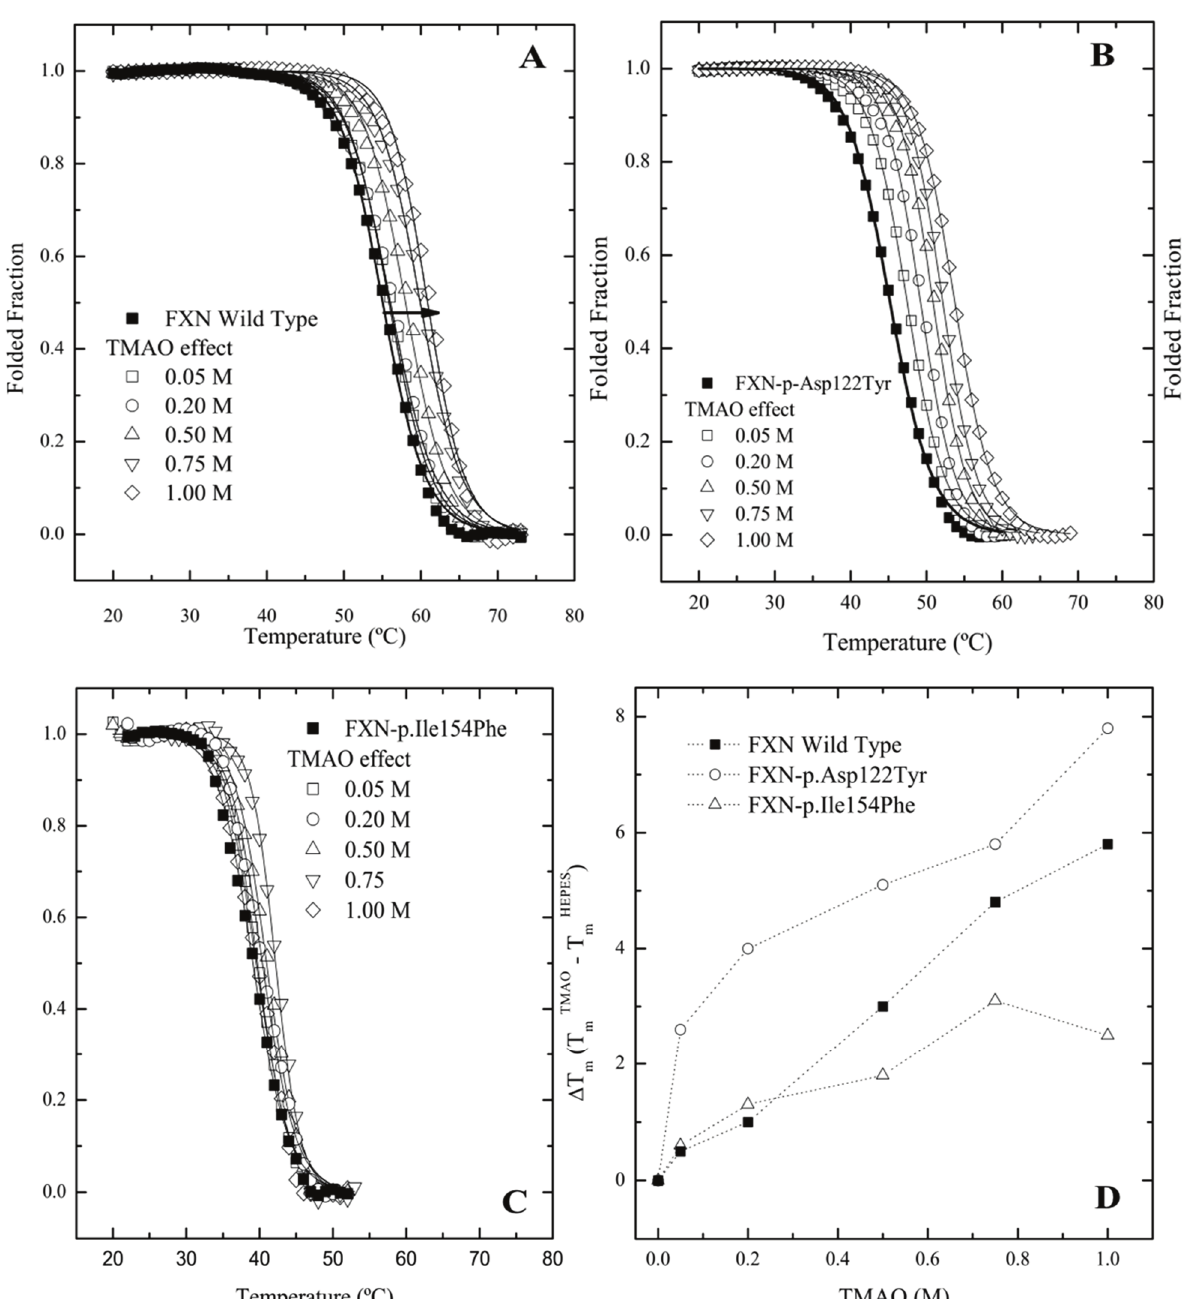
Figure 4. Differential Scanning fluorimetry (DSF) of native and variant frataxins in the absence and presence of TriMethylAmine N-oxide (TMAO). The concentration of frataxin was 4 μM. The dye Sypro orange was used to probe the temperature dependent protein unfolding reaction. The starting apparent kinetic T m values without osmolyte were 55.1 °C for wild type FXN ( A ), 48.8 °C for FXN-p.Asp122Tyr ( B ) and 39.1 °C for FXN-p.Ile154Phe ( C ) (see also Table 1). Panels ( A–C ) Melting curves for the three variants, measured by Differential Scanning Fluorimetry in the presence of increasing concentrations of two osmolytes. Panel ( D ). TMAO efficiently increases the T m values of all FXN variants in a concentration dependent way. ((cid:5)) FXN wild type, ((cid:6)) FXN-p.Asp122Tyr and ((cid:10))